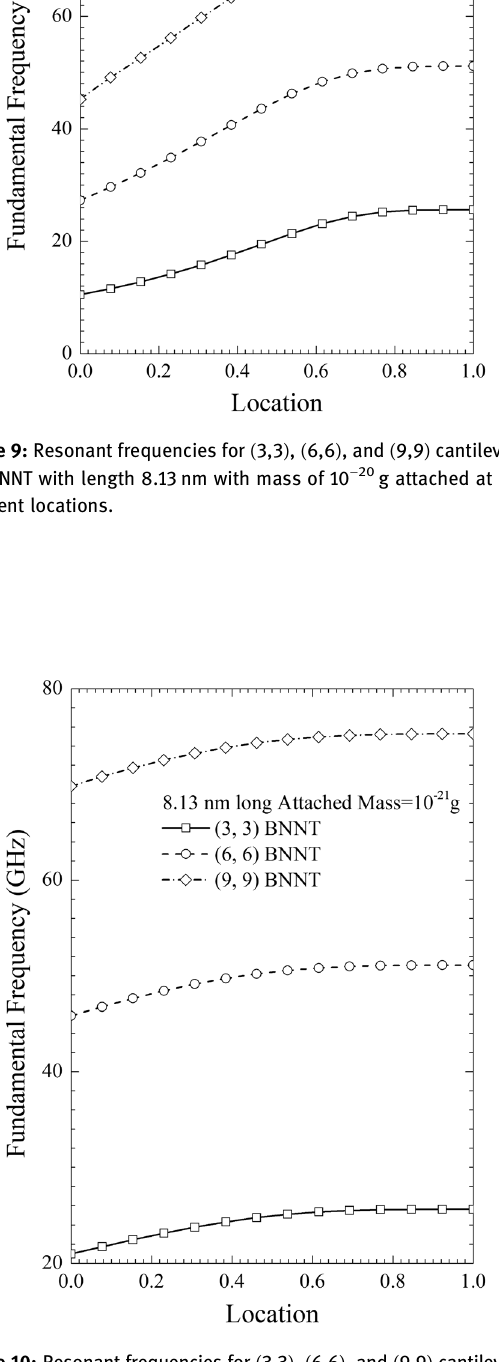
Figure 10: Resonant frequencies for ( 3,3 ) , ( 6,6 ) , and ( 9,9 ) cantilevered SW - BNNT with length 8.13nm with mass of 10 − 21 g attached at di ff erent locations.